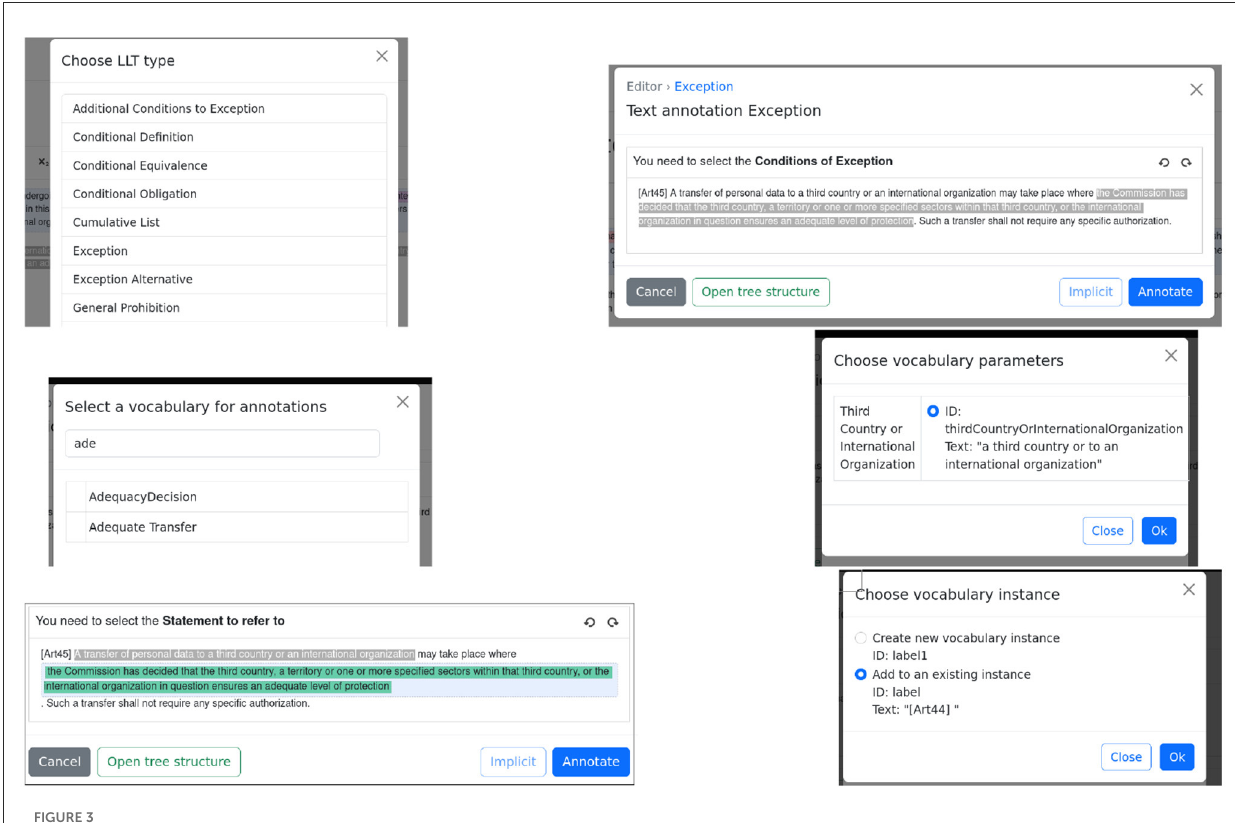
FIGURE3 The annotation process of article